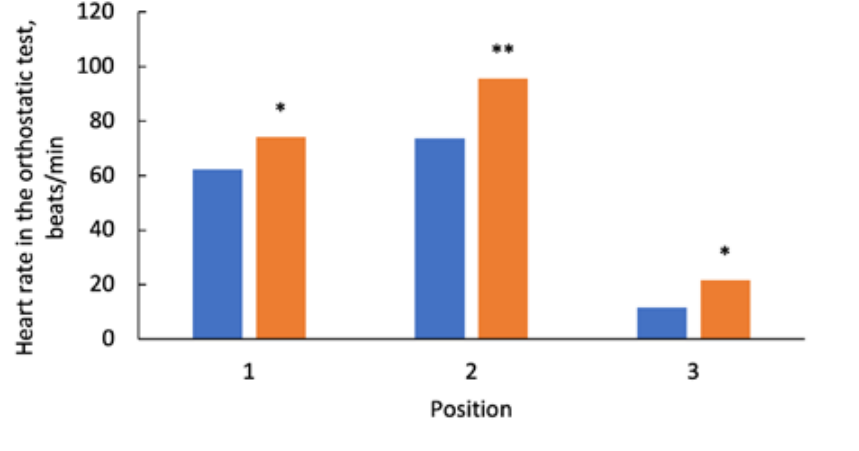
Figure 3. The value of heart rate in the orthostatic test of students of the Faculty of Arts in comparison with the Faculty of Physical Education and Sports: 1 – in the lying position, 2 – in the standing position, 3 – the difference in heart rate between the standing position and the lying position * - differences are significant at p<0.05 ** - differences are significant at